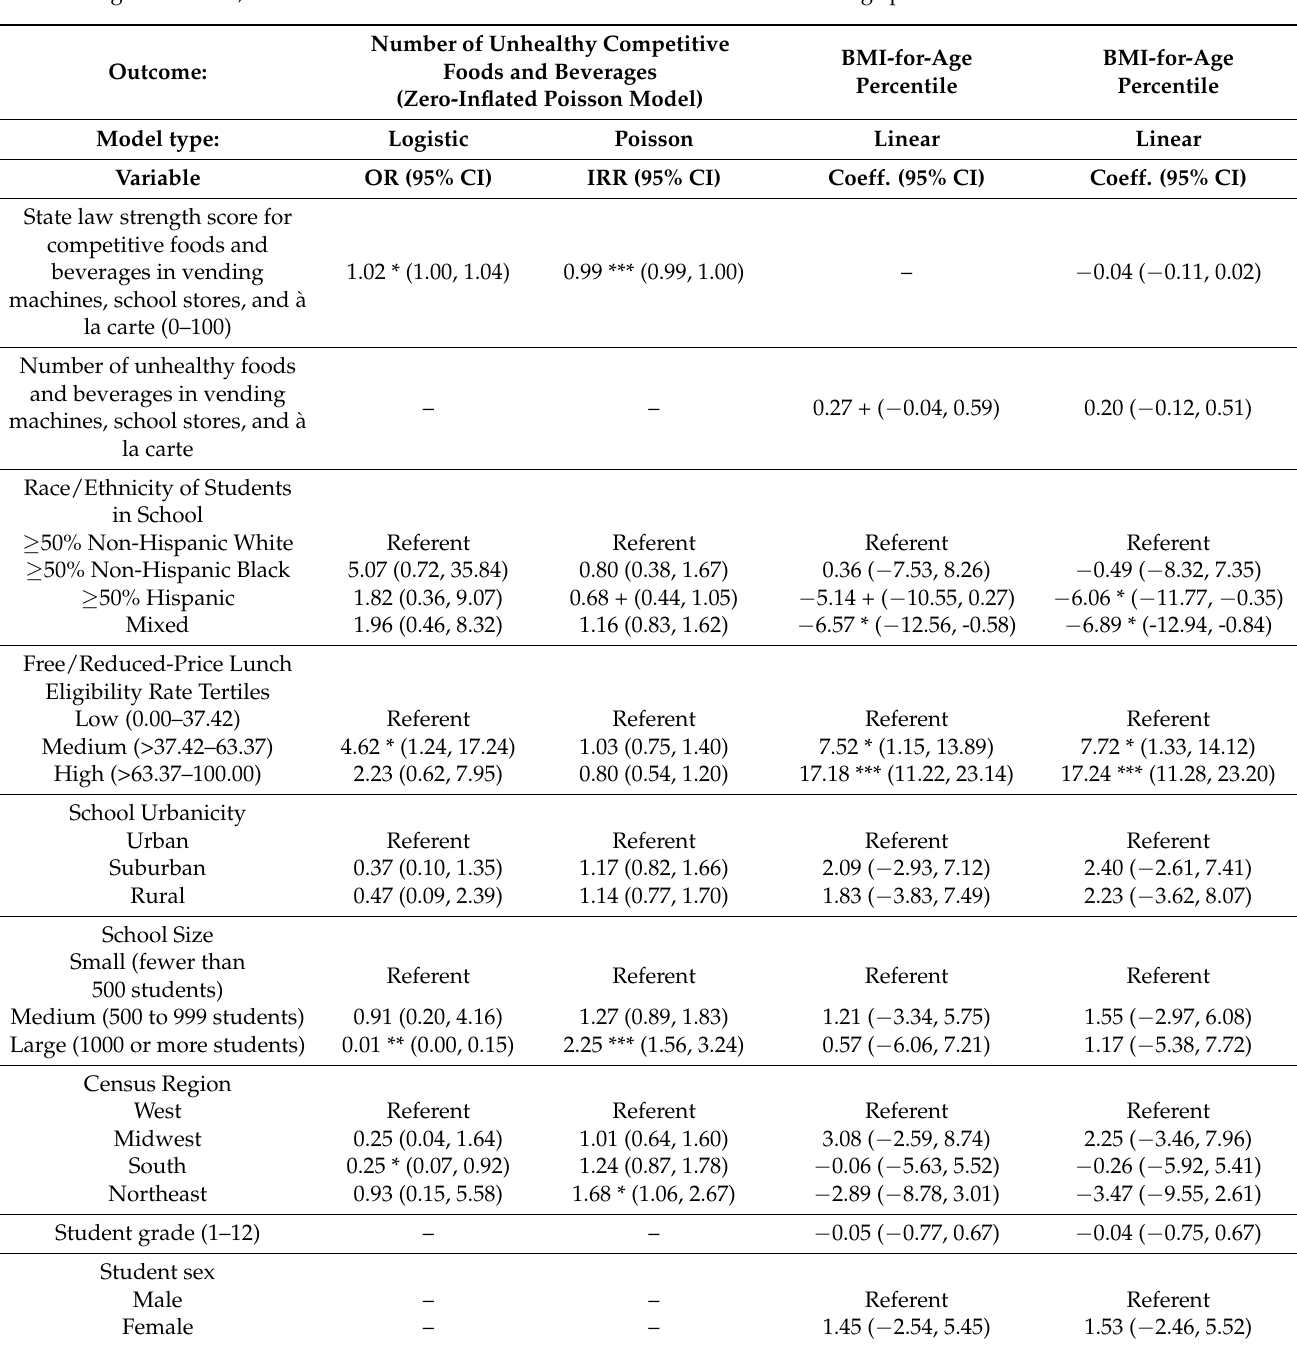
Table 3. Multivariable regression results for the association of state law, the number of unhealthy competitive foods and beverages available, and school and student characteristics with student BMI-for-age